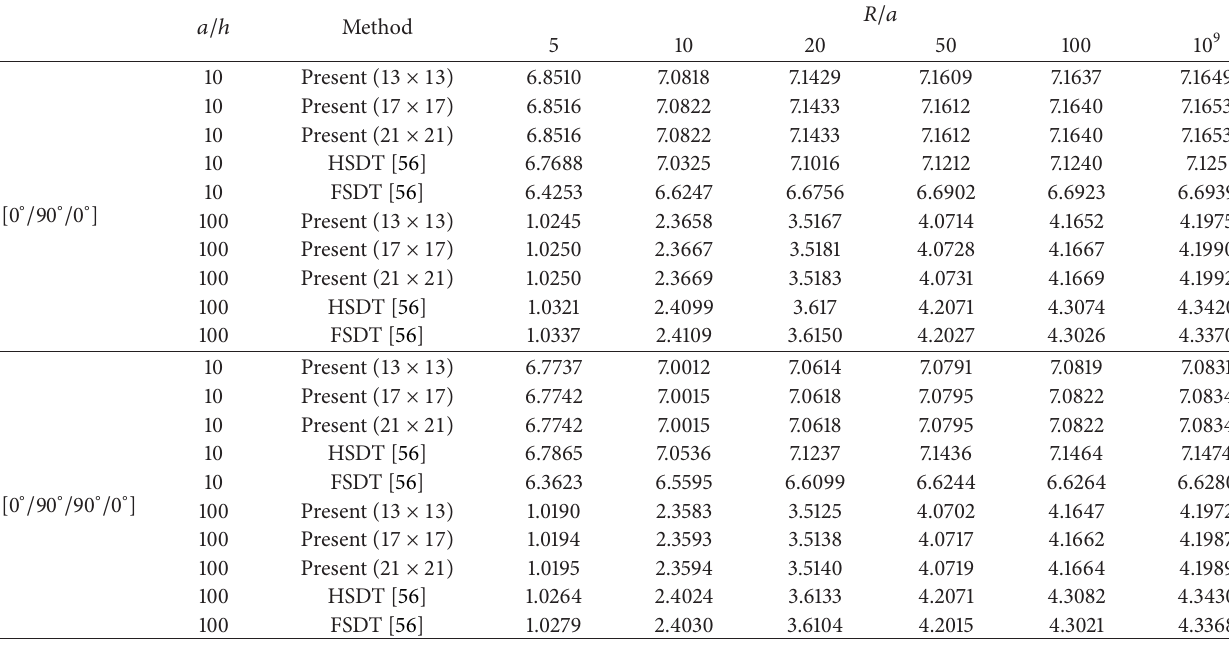
Table 1: Nondimensional central deflection, 𝑤 = 𝑤(10 2 𝐸 2 ℎ 3 /𝑃 0 𝑎 4 ) , and variation with various numbers of grid points per unit length, 𝑁 , for different 𝑅/𝑎 ratios, for 𝑅 1 = 𝑅 2